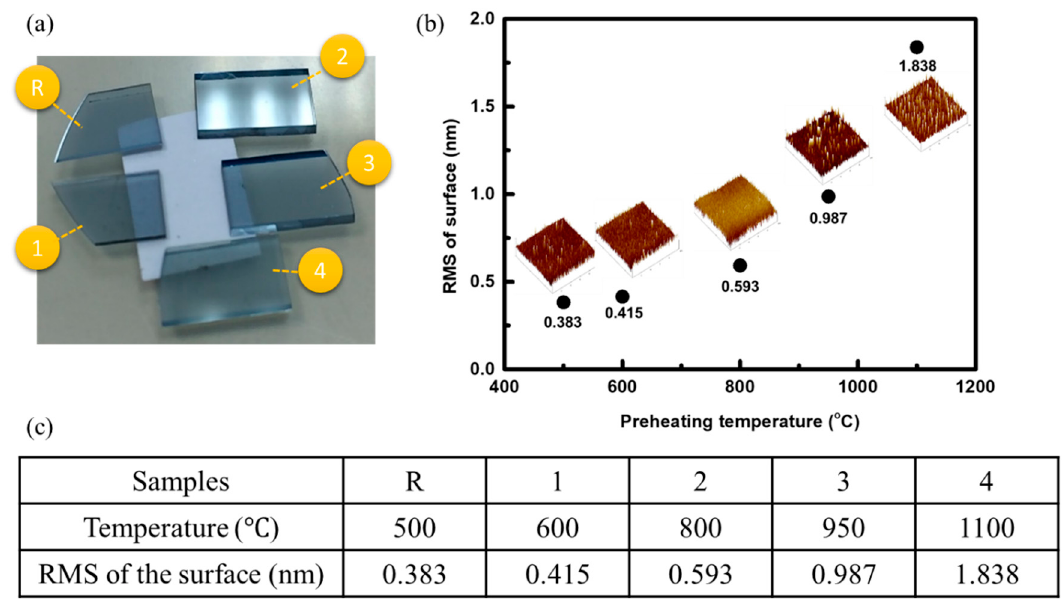
Figure 2. ( a ) The photos of ( − 2 0 1) β -Ga 2 O 3 wafers preheated at different temperatures. ( b ) The surface roughness of the ( − 2 0 1) β -Ga 2 O 3 wafers after preheating was measured using an AFM; the results were 0.383, 0.415, 0.593, 0.987, and 1.838 nm at 500, 600, 800, 950, and 1100 °C, respectively. The detail information is summarized in ( c ).